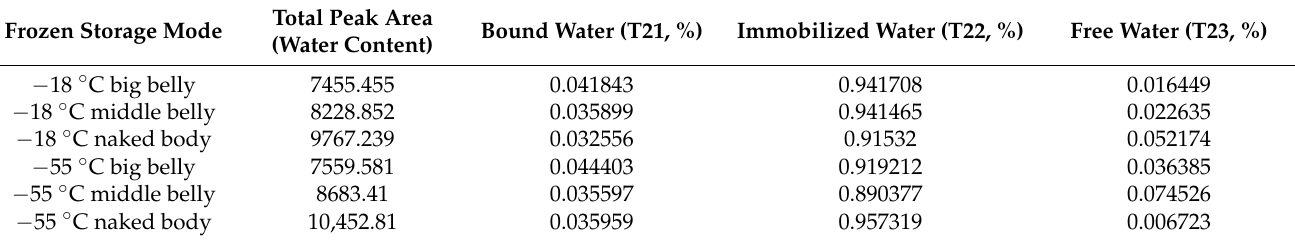
Table 2. Proportion of frozen storage peak area in different parts of tuna at different temperatures.